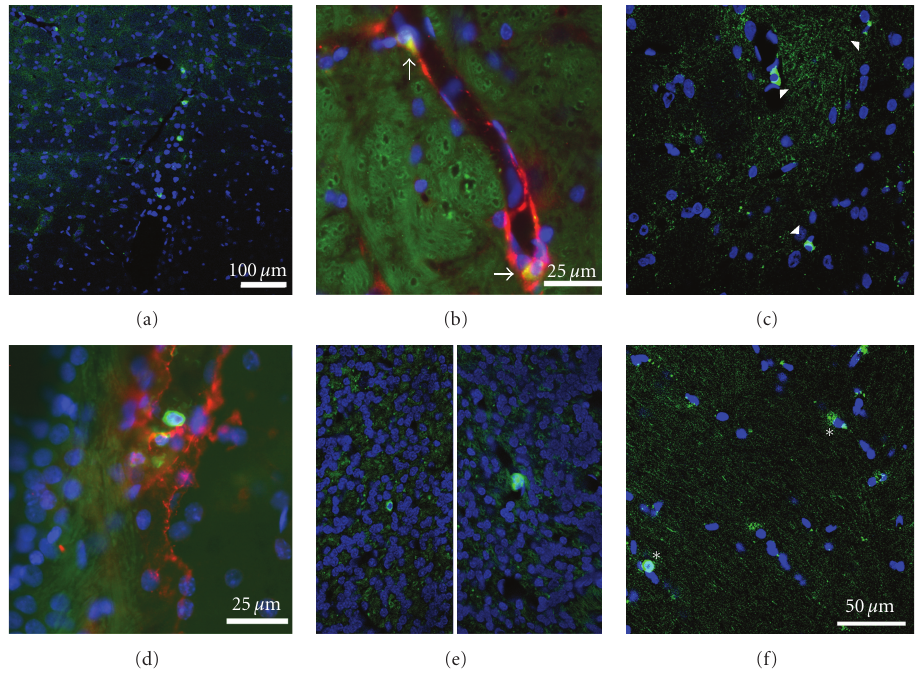
Figure 2: Immunodetection of human leucocyte antigen-ABC in the brain stem and cerebellum of 3-AP ataxic rats. (a) and (c) show HLA- ABC immunostaining (green) in the ventral (a) and dorsal (c) brain stem of 3-AP-lesioned rats receiving HuUCBMCs grafts. (b) Shows HLA-ABC (b, green) and laminin (b, red) immunoreactivity in the ventral brain stem. Note how HLA-ABC-positive cells are associated to laminin-positive blood vessels (b, yellow, white arrows) or integrated in the parenchyma (c, white arrowheads). In the cerebellum HLA-ABC- positive cells (d–f, green) are located near to the vermis in laminin-positive blood vessels (d, red), and in the parenchyma of the granular (e, green) and molecular layers (f, green, white stars) of the cerebellar cortex. Nuclei were counterstained with Hoechst 33342 (blue). Scale bar: 25 μ m (b and d), 50 μ m (c, e, and f), and 100 μ m